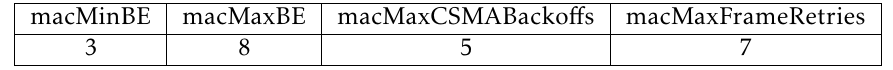
Table 1. Configuration of the underlying 802.15.4-based MAC layer; first set of experiments